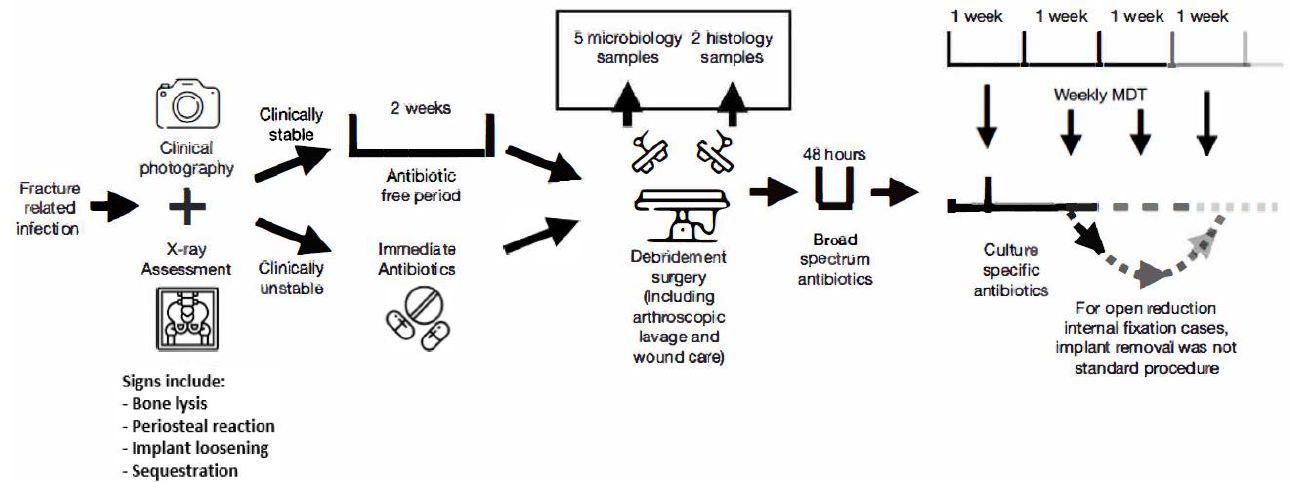
Figure 1. Treatment protocol.